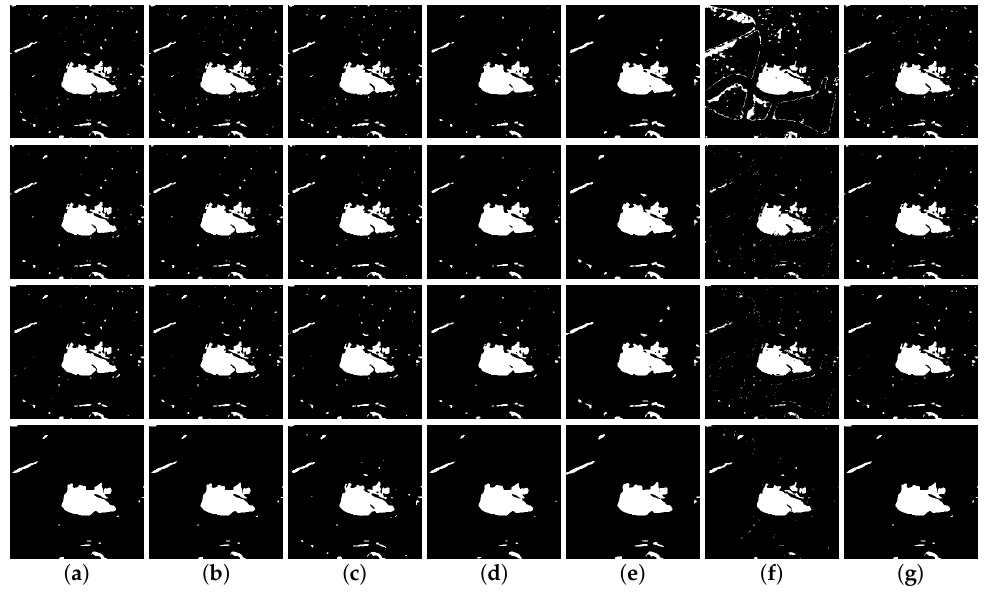
Figure 8. Results of ( a ) PCAK, ( b ) SPC, ( c ) FCM-MRF, ( d ) GTLC, ( e ) SACD, ( f ) Conradsen, and ( g ) SC-SGD on the San Francisco dataset. From top to bottom: each row contains the results of the input image, and images filtered by MMSE, SAR-BM3D, and PPB filters,